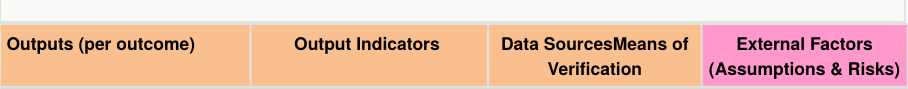
Table 2. Results framework (project